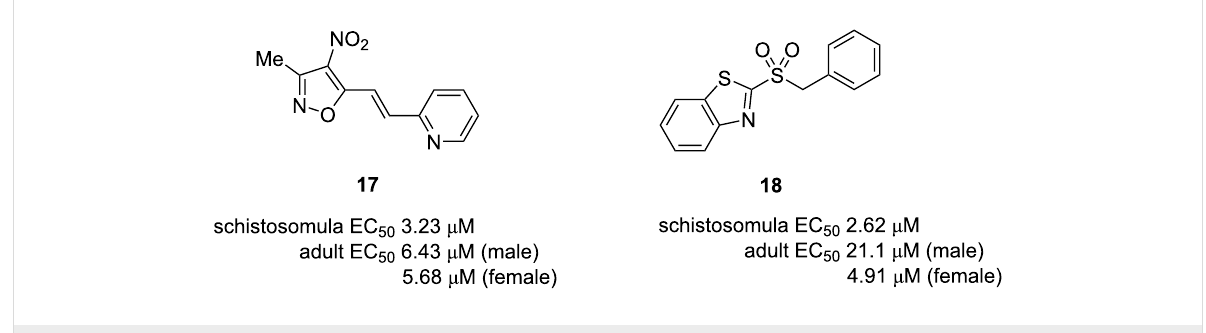
Figure 4: Inhibitors of S. mansoni thioredoxin glutathione reductase with anthelmintic activity